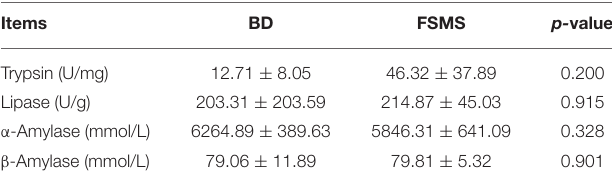
TABLE 4 | Influence of FSMS addition on porcine duodenum content digestive enzyme